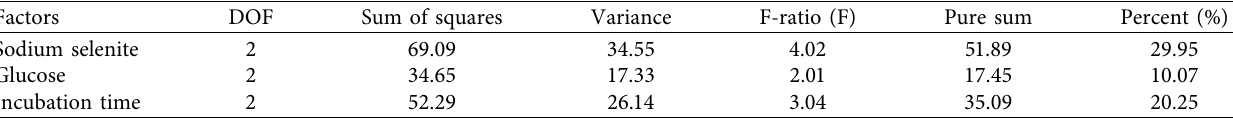
Table 4: The analysis of variance of factors affecting the growth inhibition of Candida albicans .